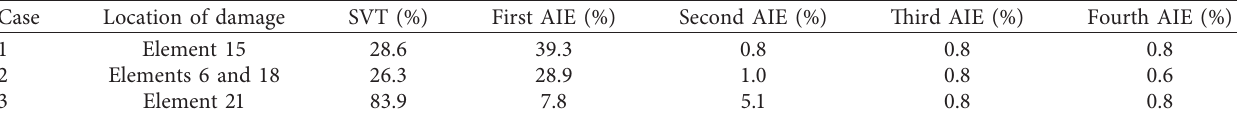
Table 1: The error degrees of damage assessment by different